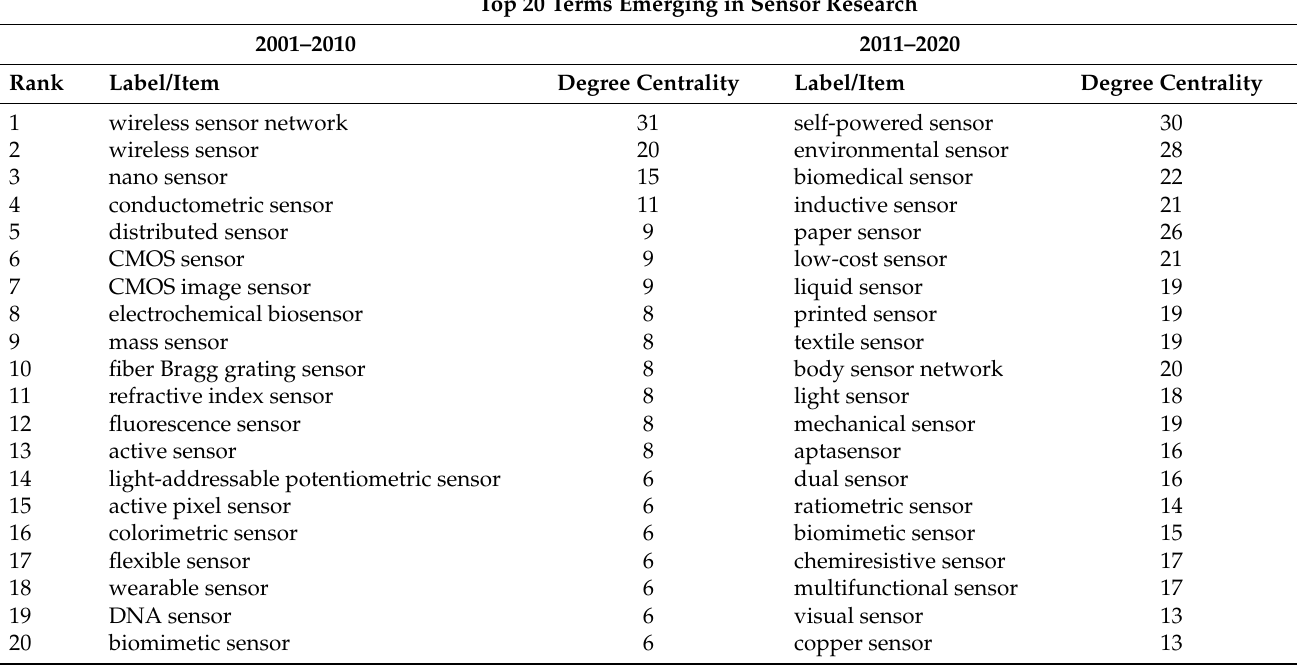
Table 3. Top 20 items in sensor research emerged in networks from 2001 to 2020.